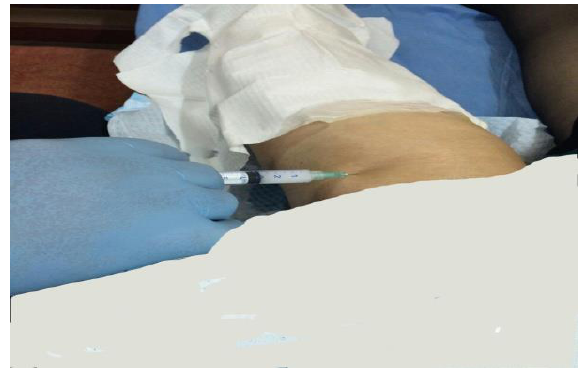
Figure 6. Post injection : moving of the knee